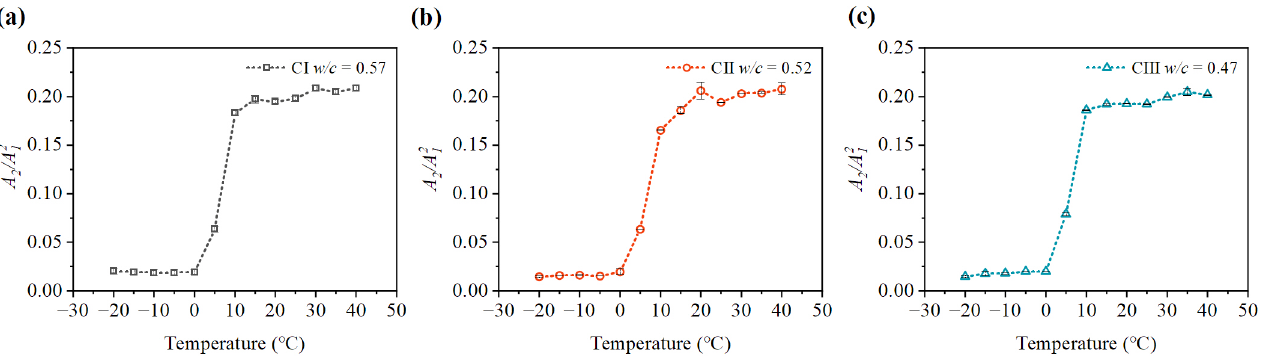
Figure 10. Variation of nonlinear parameter A 2 / A 2 parameter A 2 / A 2 of CI; ( b ) nonlinear parameter A 2 / A 2 1